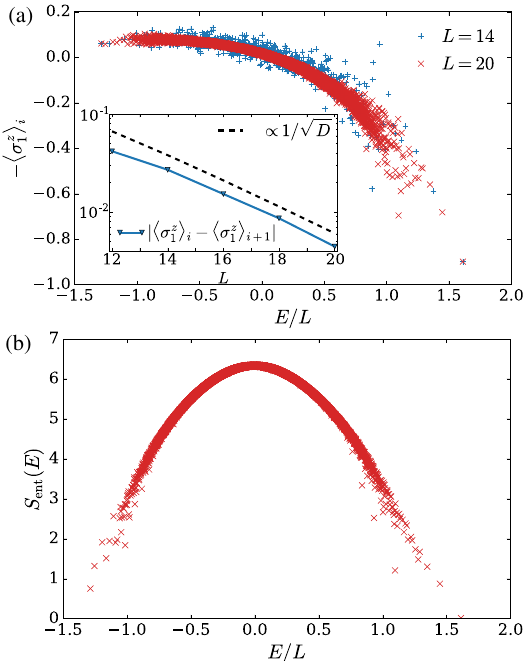
FIG. 14. (a) Comparing the expectation values of magneti- zation per spin between different system sizes suggests the applicability of ETH. The inset confirms that the fluctua- tions of magnetization between adjacent eigenstates in the energy window 0 . 19 L þ ½ − 1 ; 1 (cid:2) are suppressed, in accordance ffiffiffiffi p D with the ETH prediction, as 1 = , where D is the Hilbert space dimension. (b) Bipartite entanglement entropy of the eigenstates for L ¼ 20 shows no outliers near the middle of the spectrum. All data are obtained for the zero-momentum inversion-symmetric sector of TFIM with periodic boundary conditions using exact